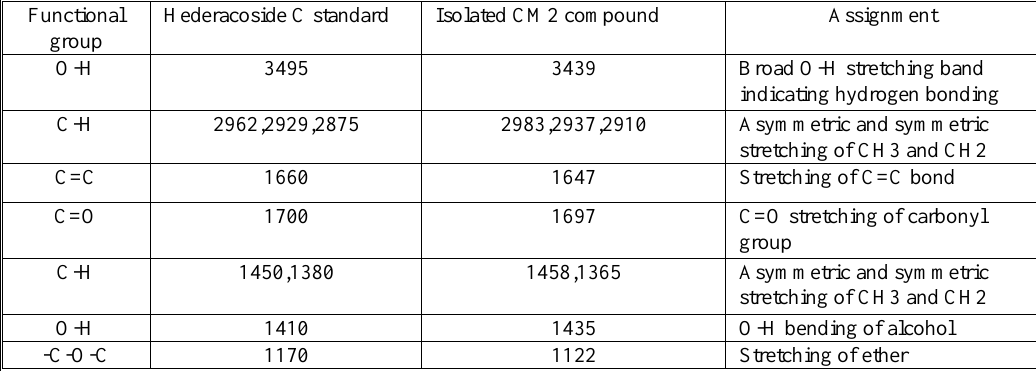
Table (6): The characteristic IR absorption bands in (cm -1 ) of the isolated hederacoside C: (16)